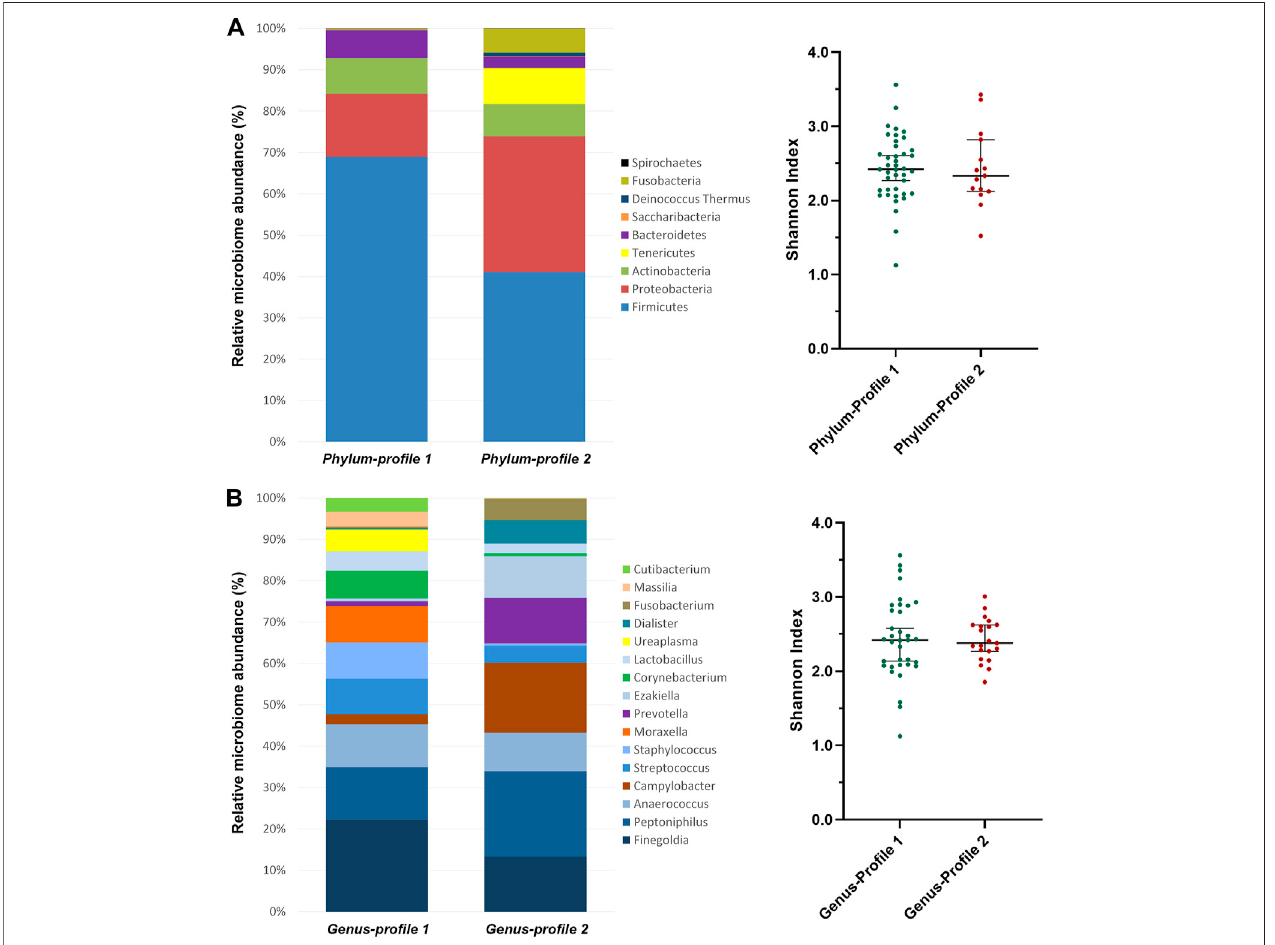
FIGURE 2 | Microbiome pro fi les ’ composition from clustering analysis of (A) phylum and (B) genus taxonomic levels. Clustering analysis was performed using the between-groupslinkagemethod basedontheEuclidean distance.Thebar-plots showtherelativeabundanceinpercentage ofthemostrepresentativebacteria ofeach pro fi le. The scatter dot-plots display the alpha diversity distribution of each pro fi le, where the Y -axis represents the Shannon index. Thin horizontal lines delimit the 95% con fi dence interval (CI), whereas the thick horizontal mark denotes the median value.